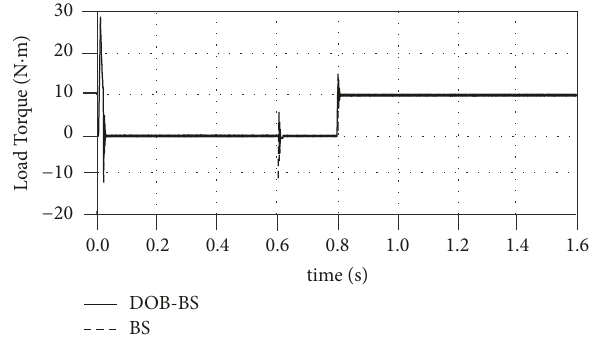
Figure 4: Load torque responses.